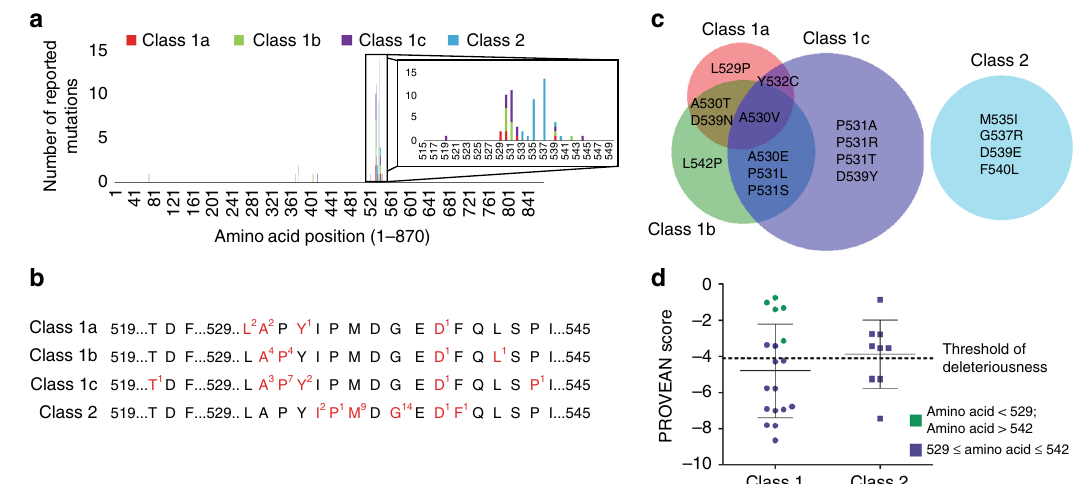
Fig. 1 Class 1 and class 2 HIF-2 α -driven diseases are associated with different mutations. a Frequency of HIF-2 α missense mutations across the primary amino acid sequence. An inset of amino acids 515-550 is provided. b The majority of HIF-2 α mutations are missense mutations located between amino acids 519 and 545. Residues that have been reported to be mutated are highlighted in red. The superscript indicates how often the residue has been mutated. c A Euler Diagram highlighting the proportion of unique mutations associated with each disease class. Examples of mutations associated with each disease class are listed. d A PROVEAN score was determined for each missense EPAS1 mutation. The more negative a score, the more damaging a mutation is predicted to be. A mutation with a score lower the − 4.1 is predicted to be deleterious with high speci fi city. Error bars indicate